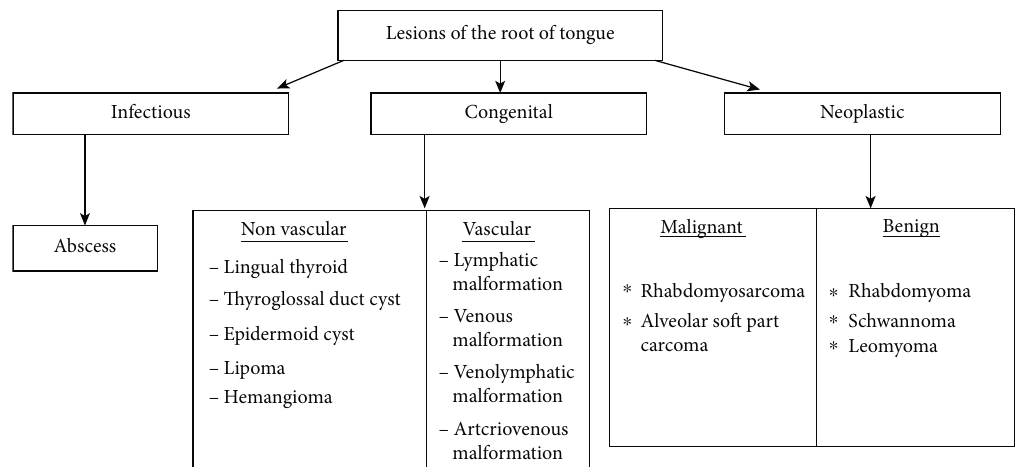
Figure 9: Base of the tongue lesions can be subcategorized as